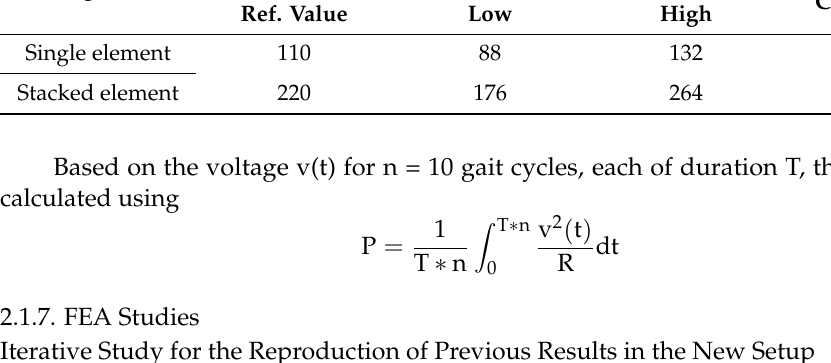
Table 4. Piezoelectric element capacity in nF according to the manufacturer for a single element with ± 20% tolerance [58] and calculated with Equation (2). Capacity acc. Manufacturer (nF) Calculated Configuration Capacity (nF) Ref. Value Low High Single element 110 88 132